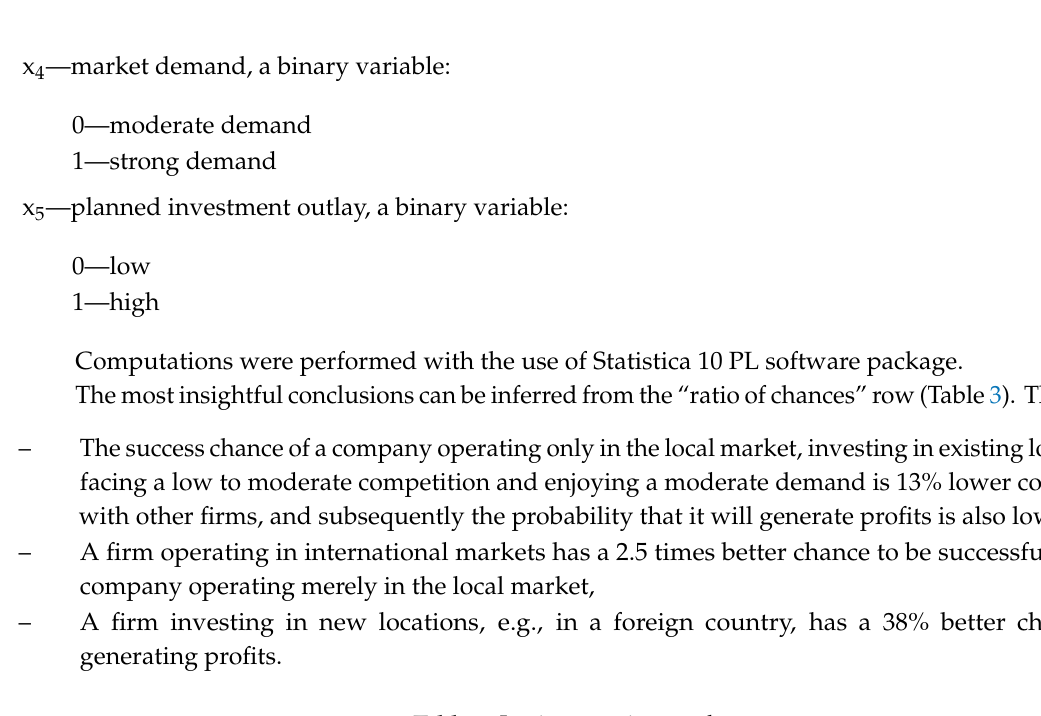
Table 3. Logit regression